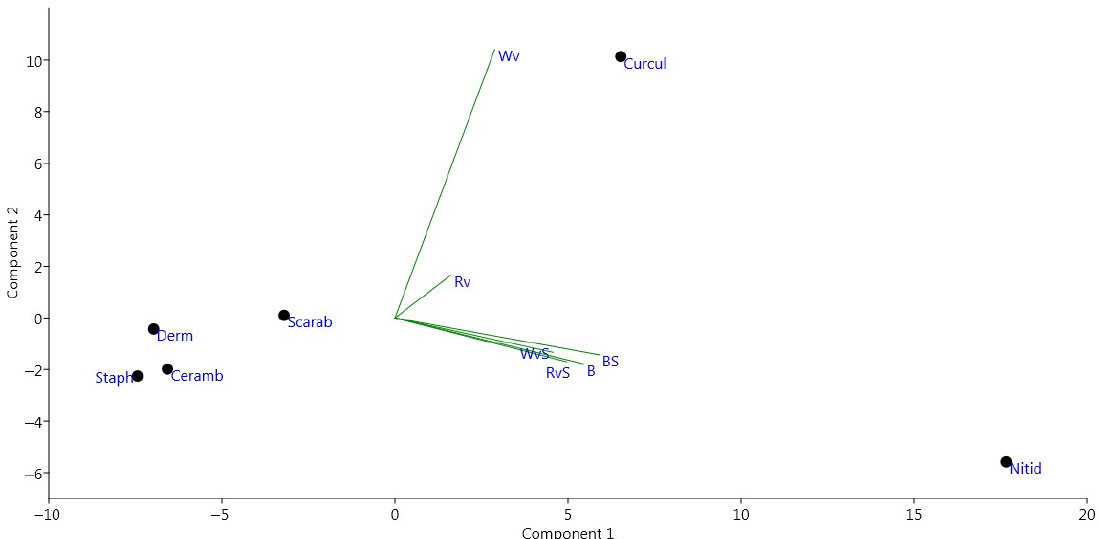
Figure 4. Canonical analysis of the number of registered specimens from different families, depending on the bait composition (beer with sugar (BS), beer without sugar (B), red wine with sugar (RVs), red wine without sugar (Rv), white wine with sugar (WvS), white wine without sugar (Wv)). Families: Derm—Dermestidae, Scarab—Scarabaeidae, Staph—Staphylinidae, Nitid—Nitidulidae, Ceramb—Cerambycidae, Curcul—Curculionidae.